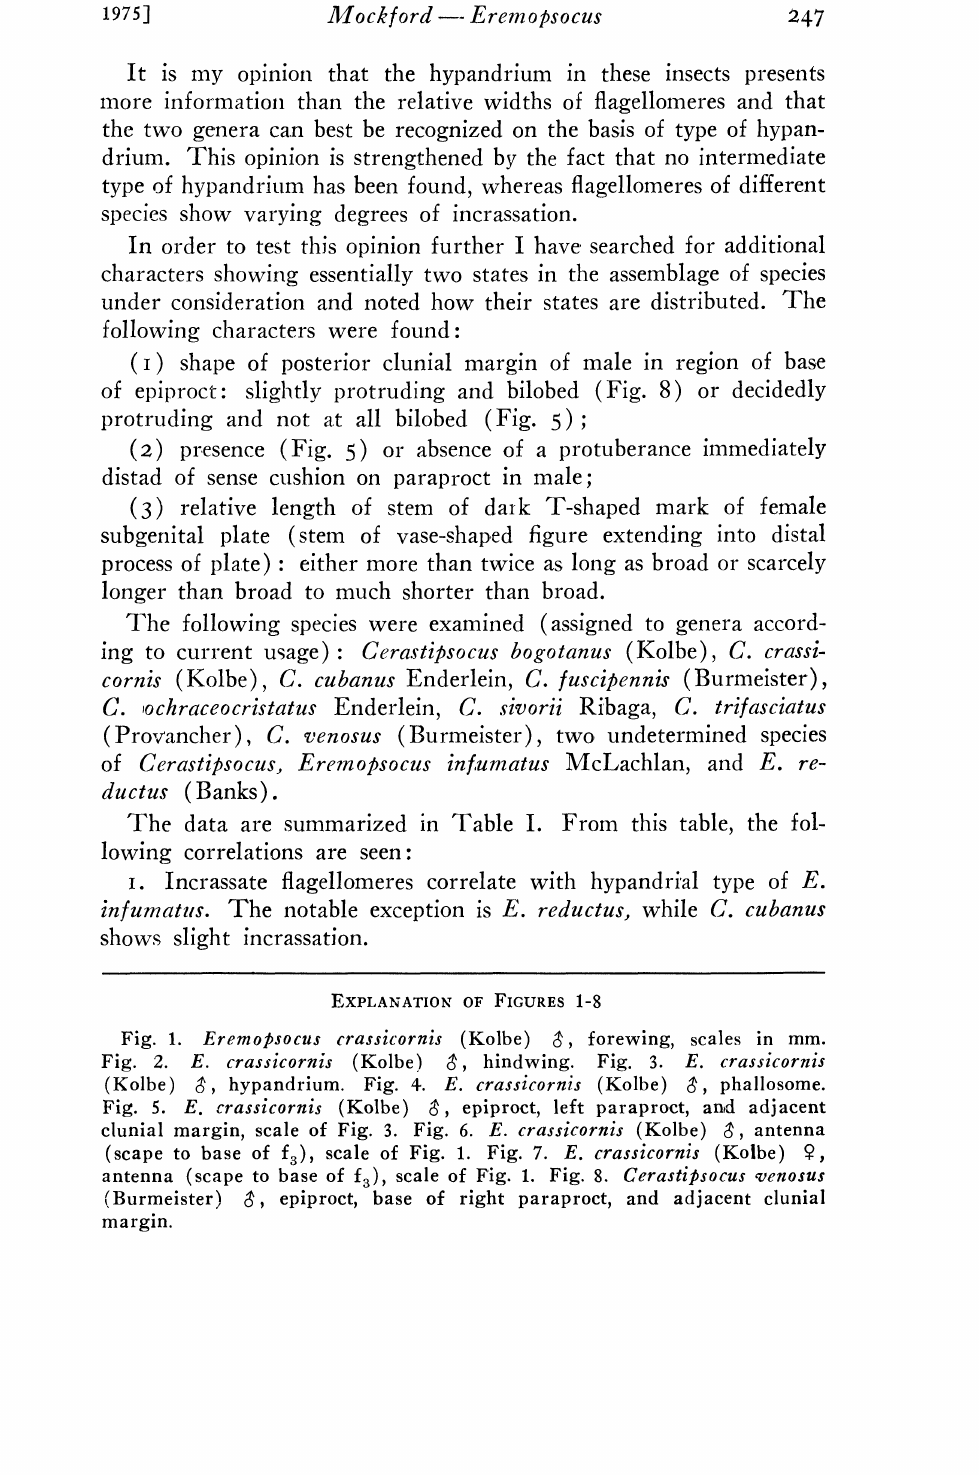
, , , forewing, scales in ram. Fig. 1. Eremol)socus crassicornis (Kolbe) , Fig. 2. E. crassicornis (Kolbe) hindwing. Fig. 3. E. crassicornis , (Kolbe) /, hypandrium. Fig. 4. E. crassicornis (Kolbe) phallosome. epiproet, left paraproet, an,d adjacent Fig. 5. E. crassicornis (Kolbe) elunial margin, scale of Fig. 3. Fig. 6. E. crassicornis (Kolbe) antenna , (scape to base of fa), scale of Fig. 1. Fig. 7. E. crassicornis (Kolbe) ?, antenna (scape to base of fa), scale of Fig. 1. Fig. 8. Cerastilsocus eenosus epiproet, base of right paraproet, and adjacent elunial (Burmeister)